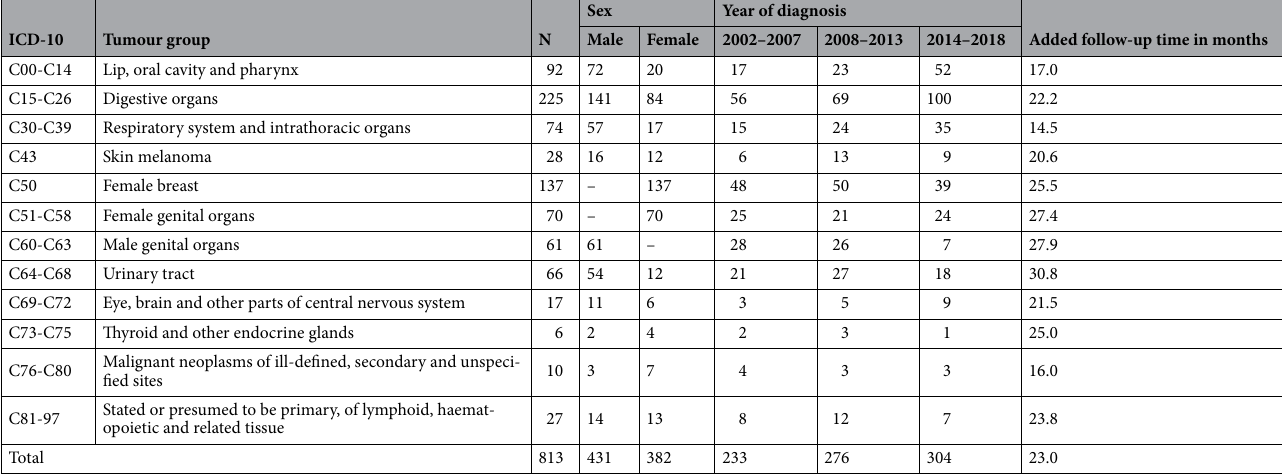
Table 1. Absolute number of cases as deaths after deterministic linkage stratified by sex, year of diagnosis, and average follow-up time added.